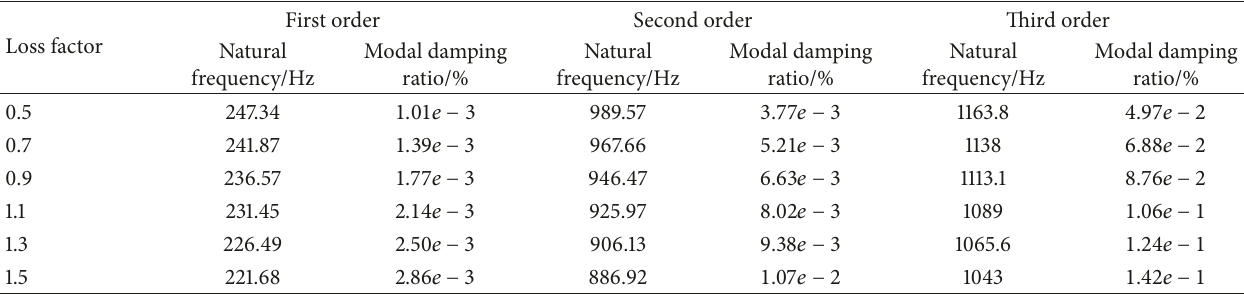
Table 9: Natural frequencies and modal damping ratios of the blade with different loss